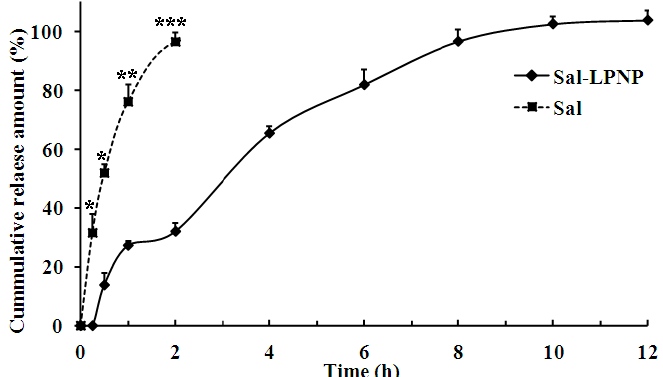
Figure 8. The in vitro release profiles of Sal and Sal-LPNPs in PBS (pH = 7.4, 0.01 M) at 37 °C. Free Sal released completely from the dialysis bag in 2 h while it took ~10 h to release the Sal from Sal-LPNPs (mean ± SD, n = 3). There were significant differences between Sal-LPNPs and free Sal groups at all time points before 2 h. * p < 0.05, ** p < 0.01, *** p < 0.001.